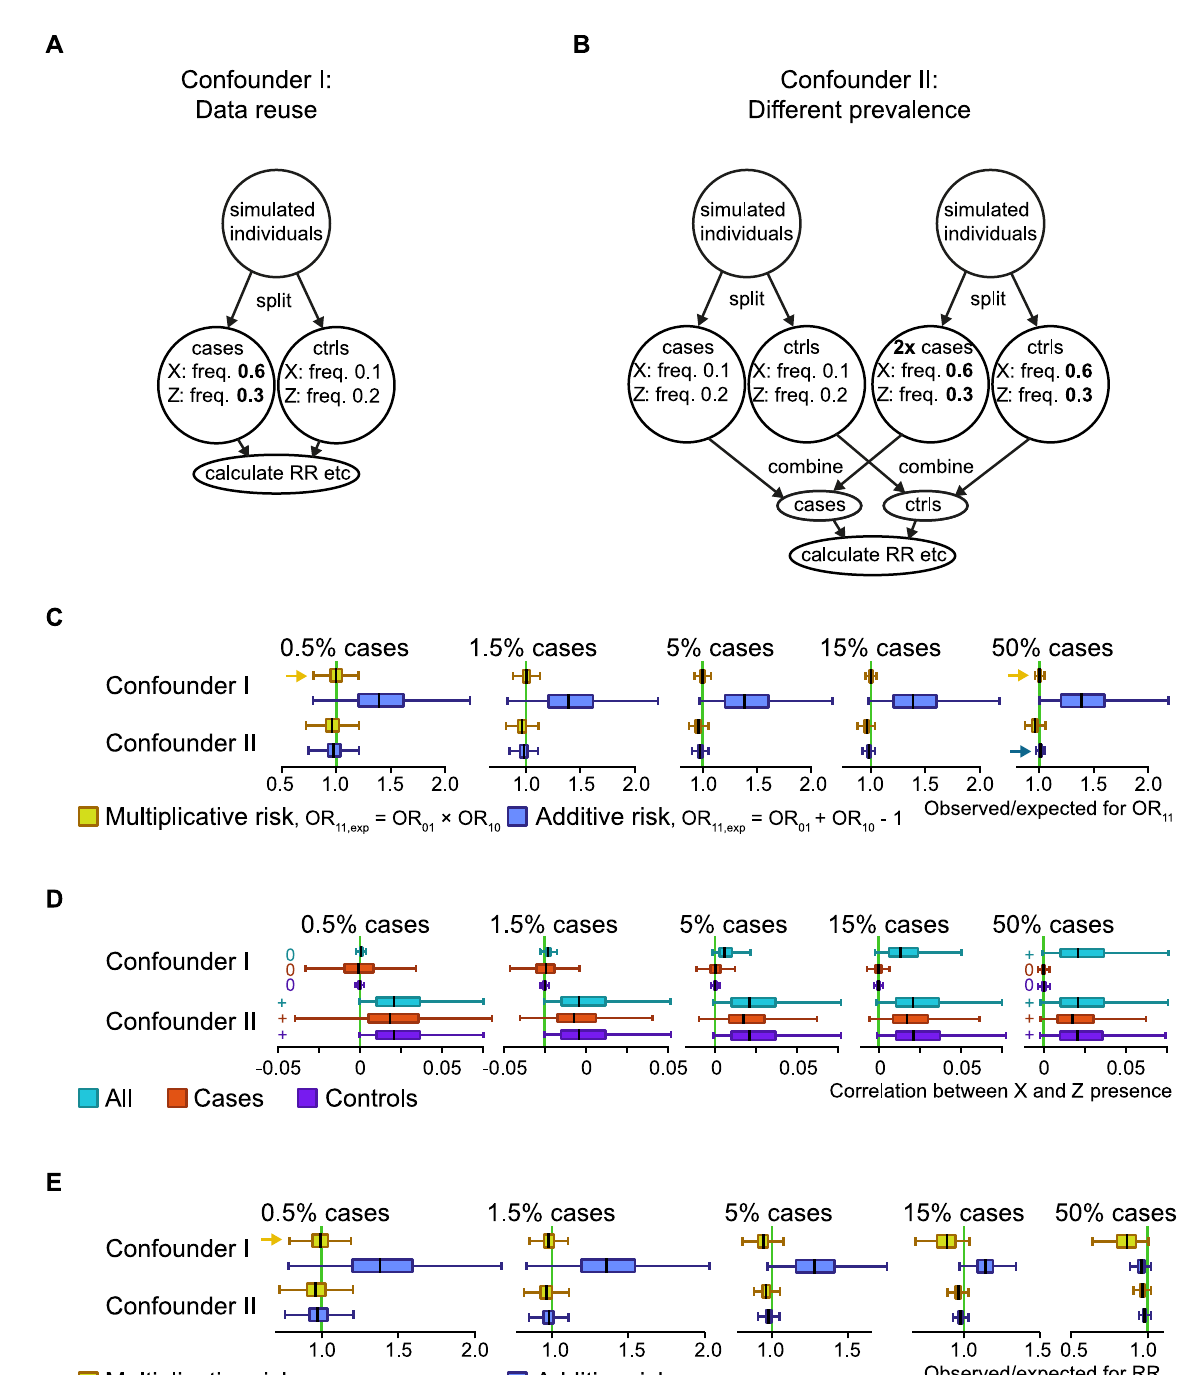
Fig 3. Two simulated confounder scenarios. A : Simulated confounder I, where the cases and controls come from different genetic backgrounds, which was simulated by testing interactions on the same data that the tested genetic risk factors were selected from. B : Simulated confounder II, where a mix of groups with both different genetic backgrounds and different prevalence rates were simulated. The numbers are example frequencies, and frequencies in bold highlight the higher frequencies of the simulated risk factors (X and Z) associated with disease. For example, “Z: freq. 0.3” means that each simulated individual in the group had a 30% chance of being assigned the risk factor Z. In each indicated circle the two risk factors have been added in an uncorrelated/independent manner. C : For each of the simulated confounder scenarios, the observed OR 11 (odds ratios for double risk) were compared to the expected ones for both the additive and multiplicative models. The boxes summarizing 1,000 simulation runs with different risk factor frequencies. The boxplots show median and quartiles for the